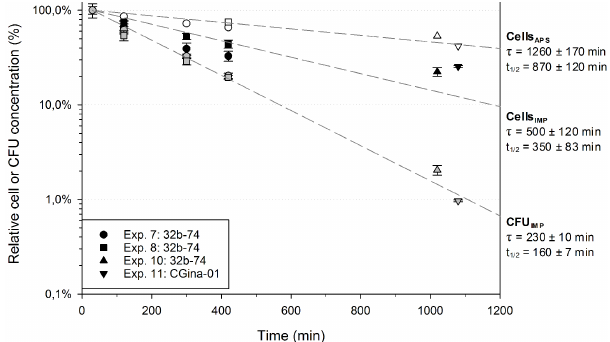
Figure 1. Temporal evolution of total airborne cell concentration measured with the APS (Cells APS , open symbols) and total and cultivable cells concentrations measured from impinger samples (Cells IMP , black symbols, and CFU IMP , grey symbols, respec- tively) of P. syringae 32b-74 and P. fluorescens CGina-01 in the chamber, relative to the concentrations measured 30min after spray- ing cell suspensions. Error bars are standard deviations from the mean of triplicate samples. The curves show fitted exponential tem- poral decays. For total particles: Pearson’s r = 0 . 992, n = 7; for total cells: Pearson’s r = 0 . 937, n = 9; for cultivable cells: Pear- son’s r = 0 . 990, n = 9. Corresponding calculated time constants ( τ ) and half-life times ( t 1 / 2 ) are indicated on the right of the fig- ure (mean ± standard